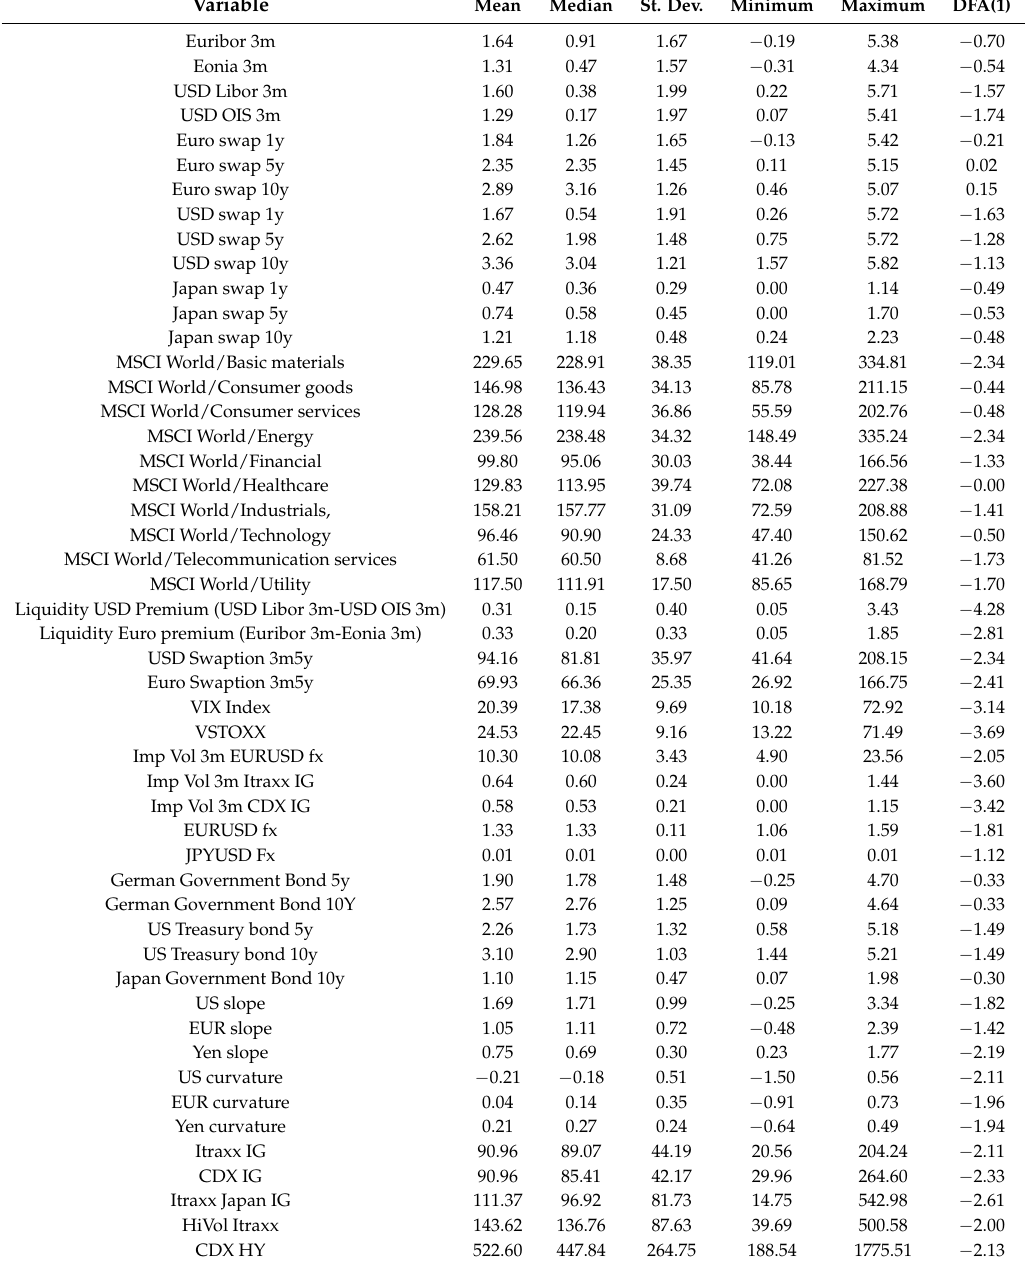
Table 1. Economic and financial indicators: main statistics.